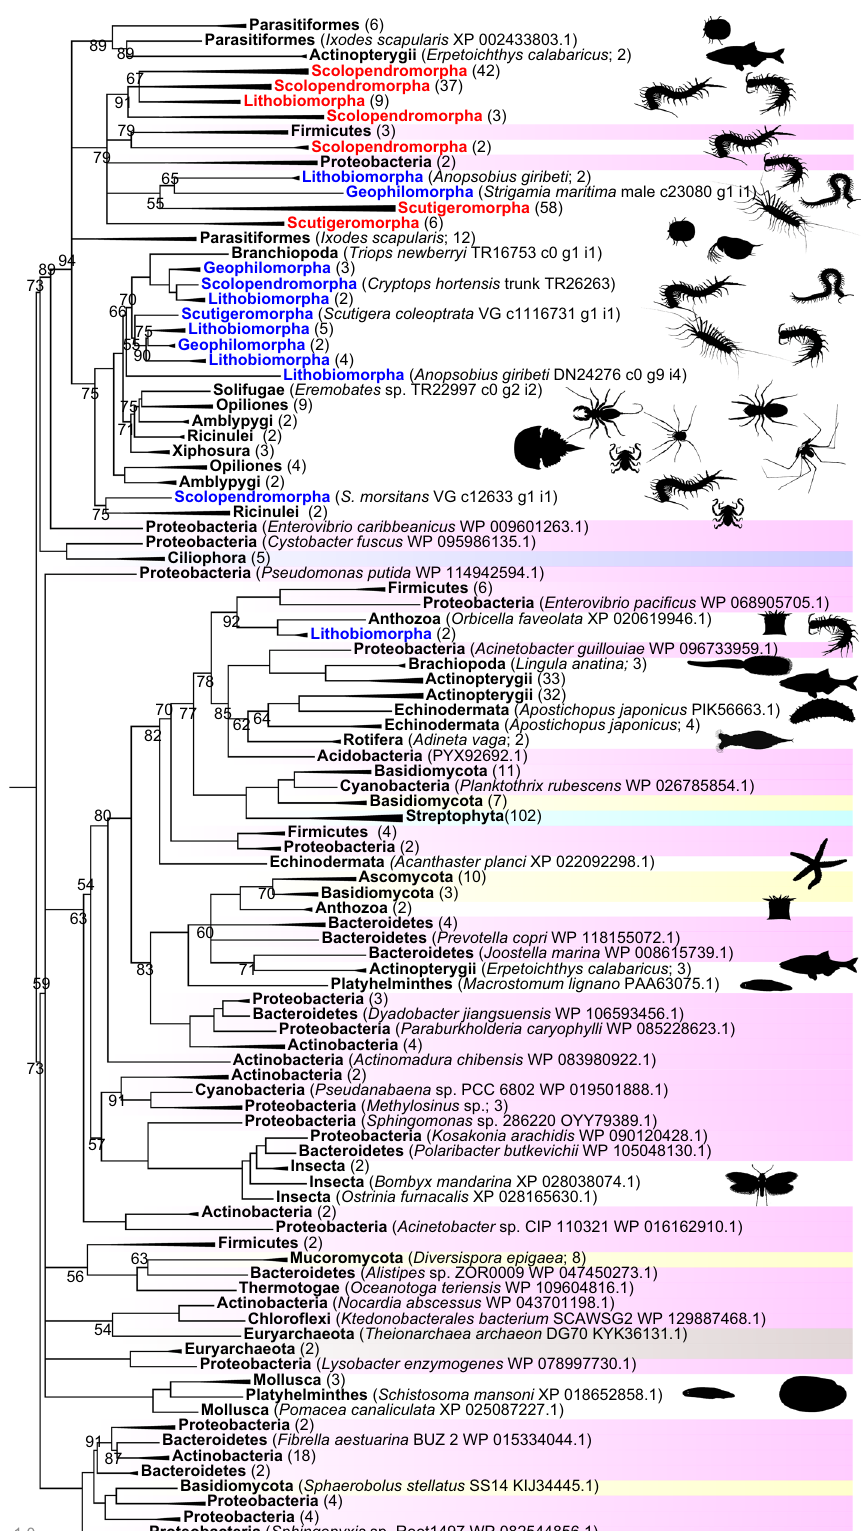
sequences are very distinct from their nearest bacterial relatives (see below), which is re fl ected by the relatively long branch leading to the centipede clade. Lastly, a morphological study of the venom system of L. for fi catus found no evidence for bacterial symbionts in the venom producing and secreting tissues 35 .